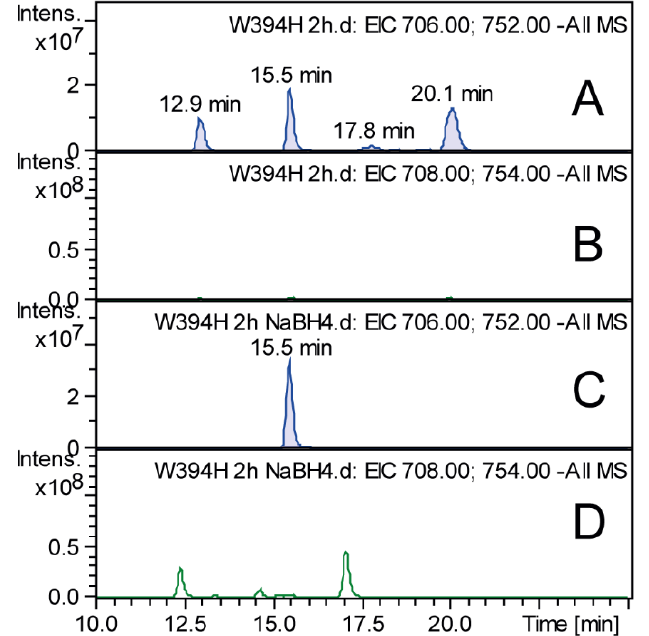
Figure 8. LNT isomer reduction. Extracted ion chromatograms of native LNT isomers (blue m / z 706 and 752) and LNT alditols (green, m / z 708 and 754) from the native W394H 2 h sample ( A , B ) and from the reduced version of the same sample ( C , D